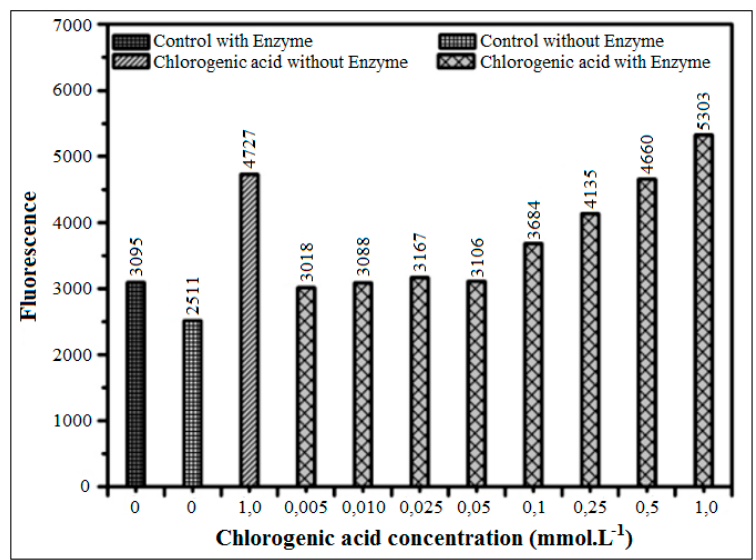
Figure 12. Inhibition of AGEs formation using different concentrations of chlorogenic acid determined by the glucose assay (37 °C) in the presence or absence of XO in pure phosphate buffer (pH = 6.6) with incubation for 48 h.